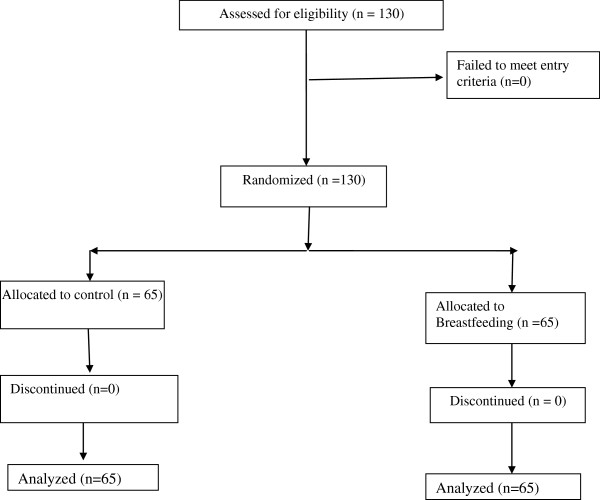
The trial flowchart.